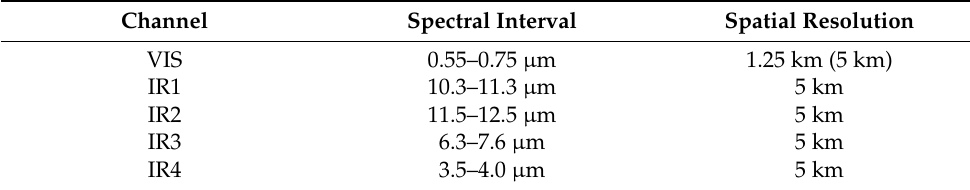
Table 1. The specific information of each